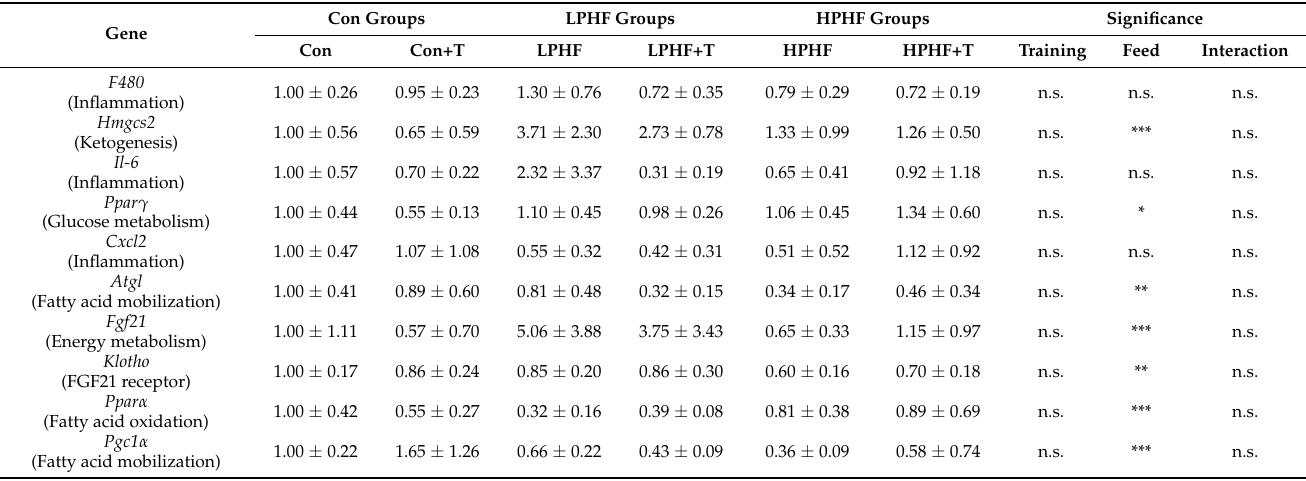
Table 9. Effects of LPHF, HPHF, and/or training on liver gene